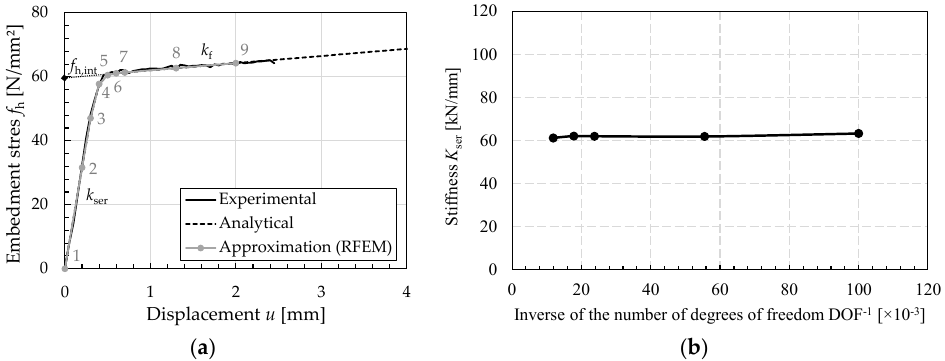
Figure 12. (a) Comparison of experimental embedment curve, analytical approximation and ap- Figure 12. ( a ) Comparison of experimental embedment curve, analytical approximation and approxi- proximation by individual points [34]; (b) Numerically determined stiffness K ser when varying the mation by individual points [34]; ( b ) Numerically determined stiffness K ser when varying the number number of embedment springs (plotted over the inverse of the degrees of freedom DOF -1 ) for the of embedment springs (plotted over the inverse of the degrees of freedom DOF − 1 ) for the component component tests with beech LVL. tests with beech